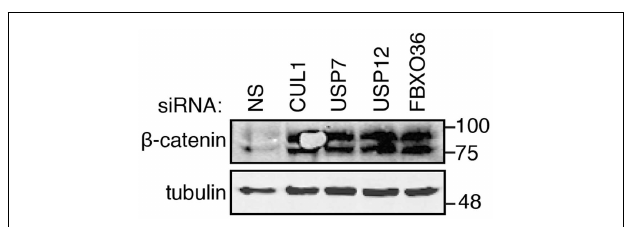
FIGURE 11 |Western blot evaluation of beta-catenin ( β -catenin) in cells treated with the indicated siRNAs .Tubulin is shown as a loading control. Molecular weights are shown in